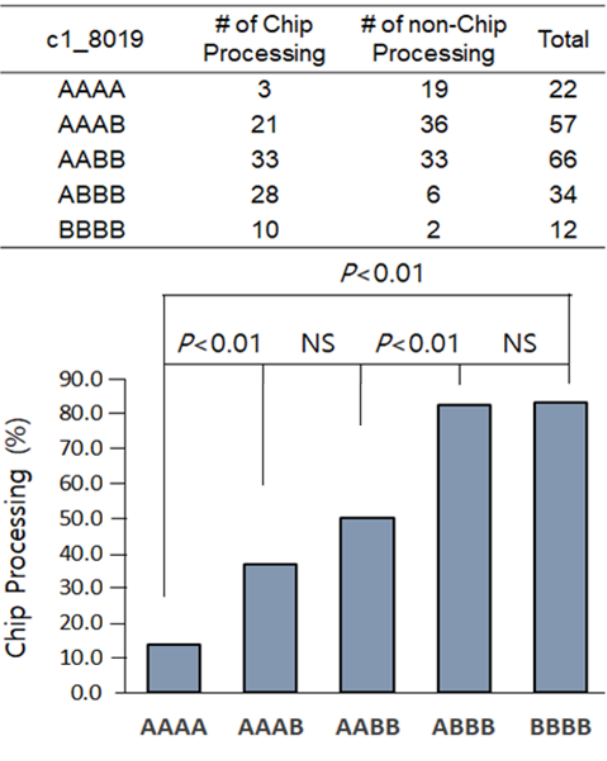
Figure 3. Correlation between the c1_8019 and chip processing. The percentage of chip processing in different genotype of SNP c1_8019. Significant differences among different genotypes were calculated using the z-score test for two population proportions. NS; no significance. Table 1. Summary of top significant SNPs associated with chip processing.